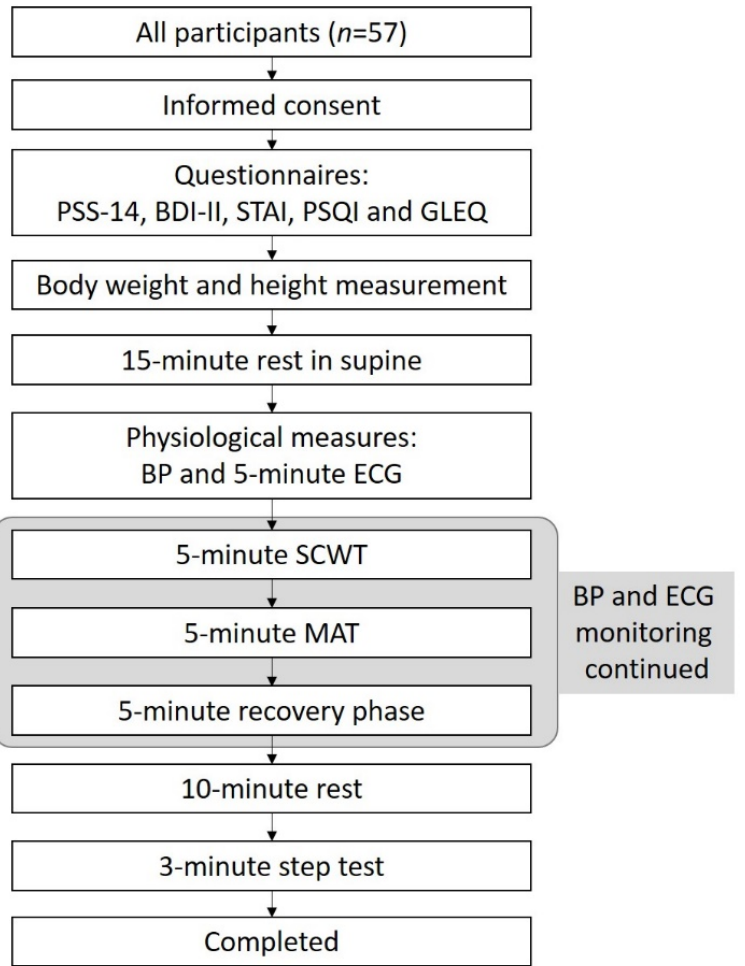
Figure 1 . Flowchart of study procedures. PSS-14, Perceived Stress Scale-14; BDI-II, Beck Depression Inventory; STAI, State-Trait Anxiety Inventory; PSQI, Pittsburgh Sleep Quality Index; GLEQ, Goldin Leisure-time Exercise Questionnaire; BP, blood pressure; ECG, electrocardiogram; SCWT, the Stroop color and word test; MAT, the mental arithmetic task.